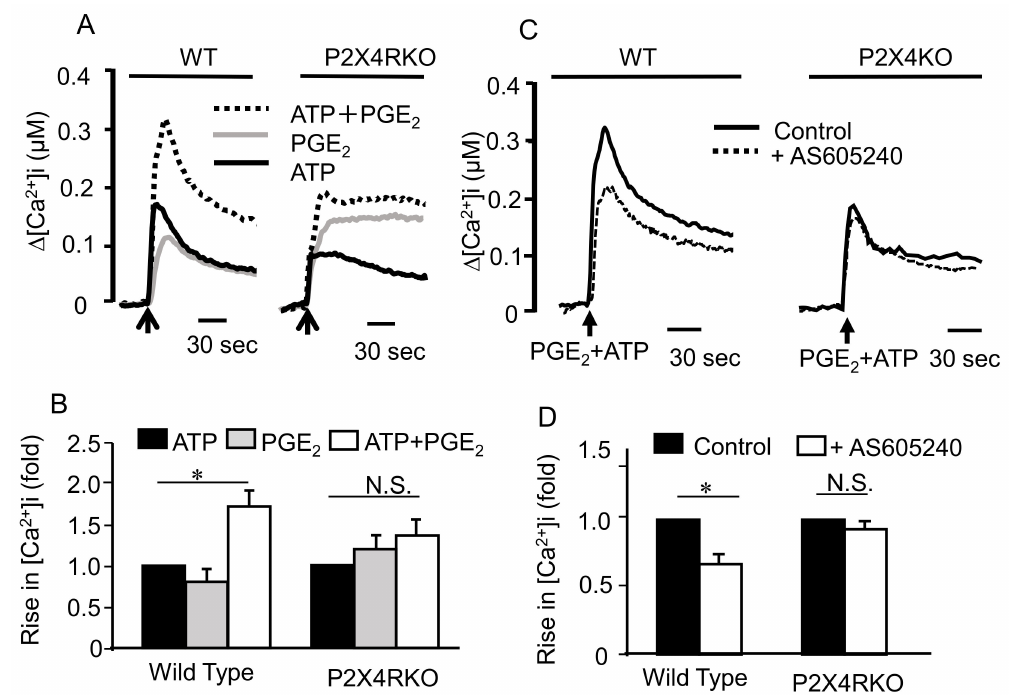
Figure 6. E ff ects of co-stimulating bone marrow-derived mast cells (BMMCs) with ATP and prostaglandin (PG)E 2 on intracellular Ca 2 + concentration ([Ca 2 + ]i) levels. ( A ) BMMCs prepared from widg type (WT) or P2X4 receptor deficient (P2X4RKO) mice were loaded with Fura-2 acetoxymethyl ester and changes in [Ca 2 + ]i were monitored after stimulating with ATP (black line), PGE 2 (gray line), or ATP plus PGE 2 (dotted line) at the time indicated by the arrow. The Ca 2 + data are representative of four independent experiments. ( B )Summary of the data obtained in A. Results are indicated as fold of ATP-induced response (WT; 205 ± 38 nM, n = 4, P2X4RKO; 115 ± 16 nM, n = 4). Data are shown as the mean ± SEM ( n = 4). N.S.; no significant di ff erence, * p < 0.05 indicates a significant di ff erence. ( C ) BMMCs prepared from WT or P2X4RKO were preincubated with or without the PI3K γ inhibitor AS605240 (1 µ M) for 5 min and then stimulated with ATP (100 µ M) plus PGE 2 (1 µ M). The superimposed [Ca 2 + ]i changes are representative of at least four di ff erent BMMC preparations obtained from di ff erent animals. ( D ) Summary of the data obtained in C. Results are indicated as fold of control response (WT; 342 ± 45 nM, n = 3, P2X4RKO; 158 ± 29 nM, n = 4). Data are shown as the mean ± SEM ( n = 3–4).